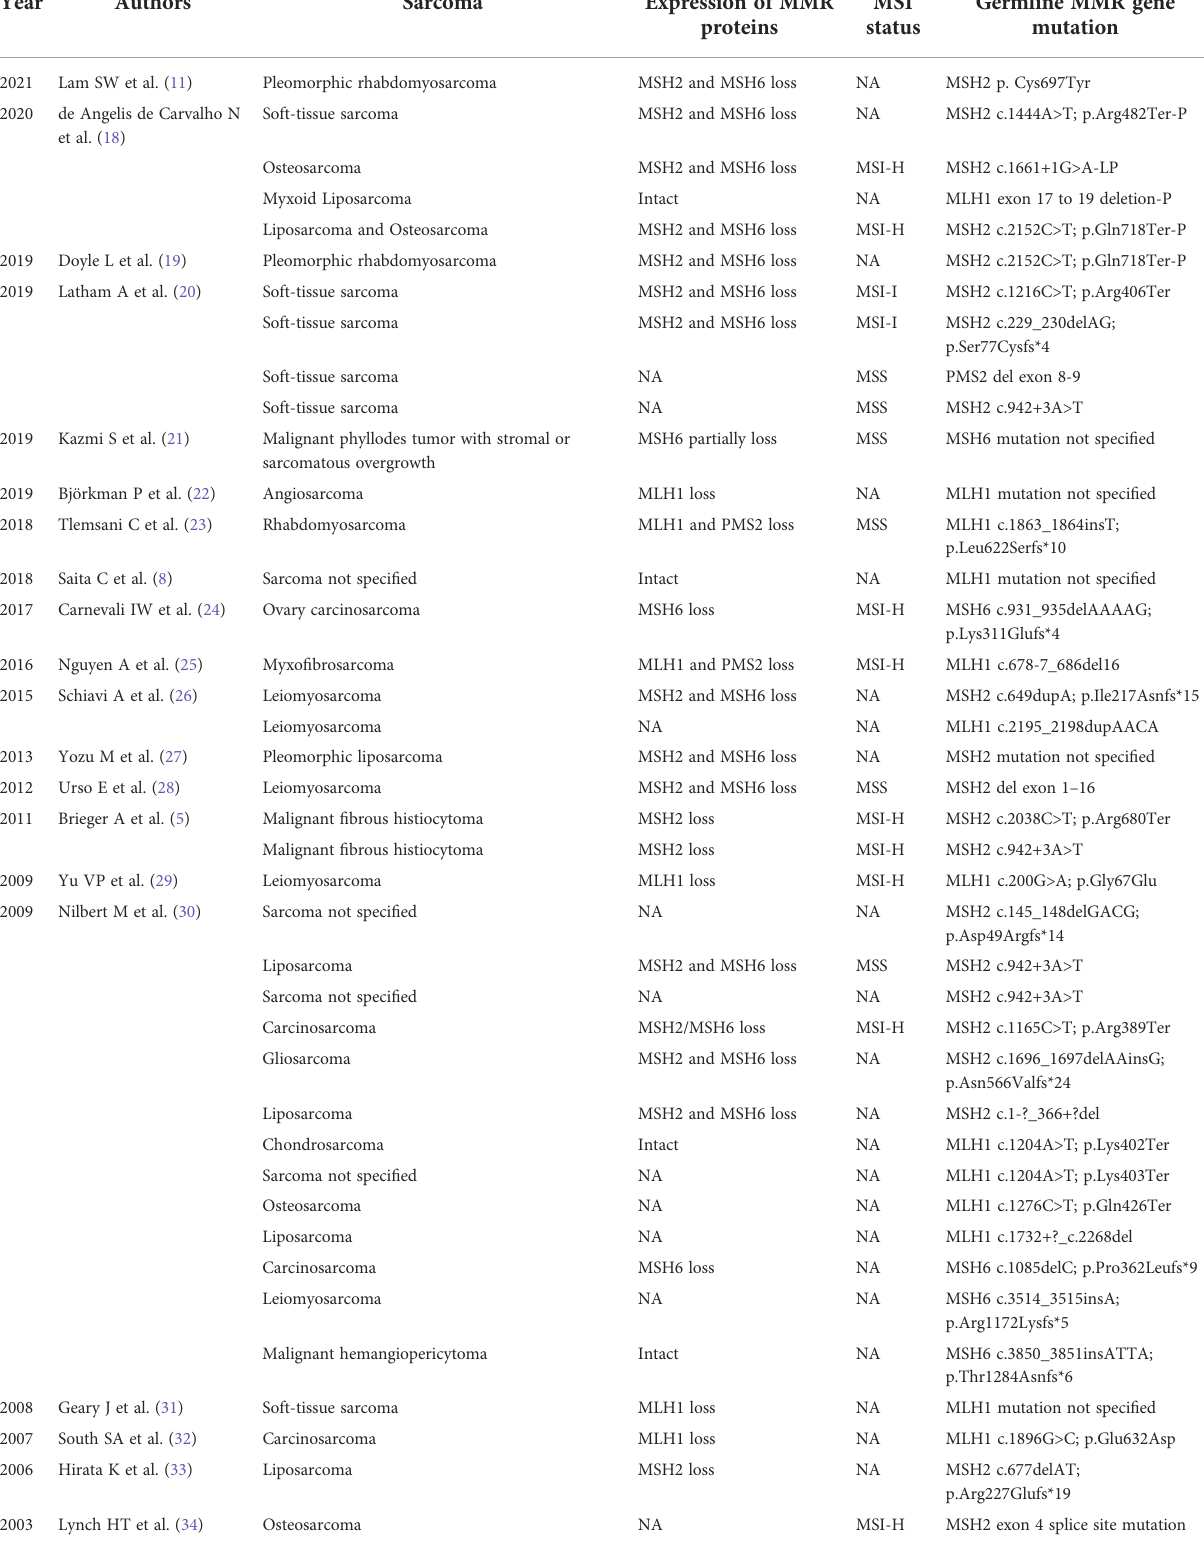
TABLE 1 Overview of sarcomas linked to Lynch syndrome published in the